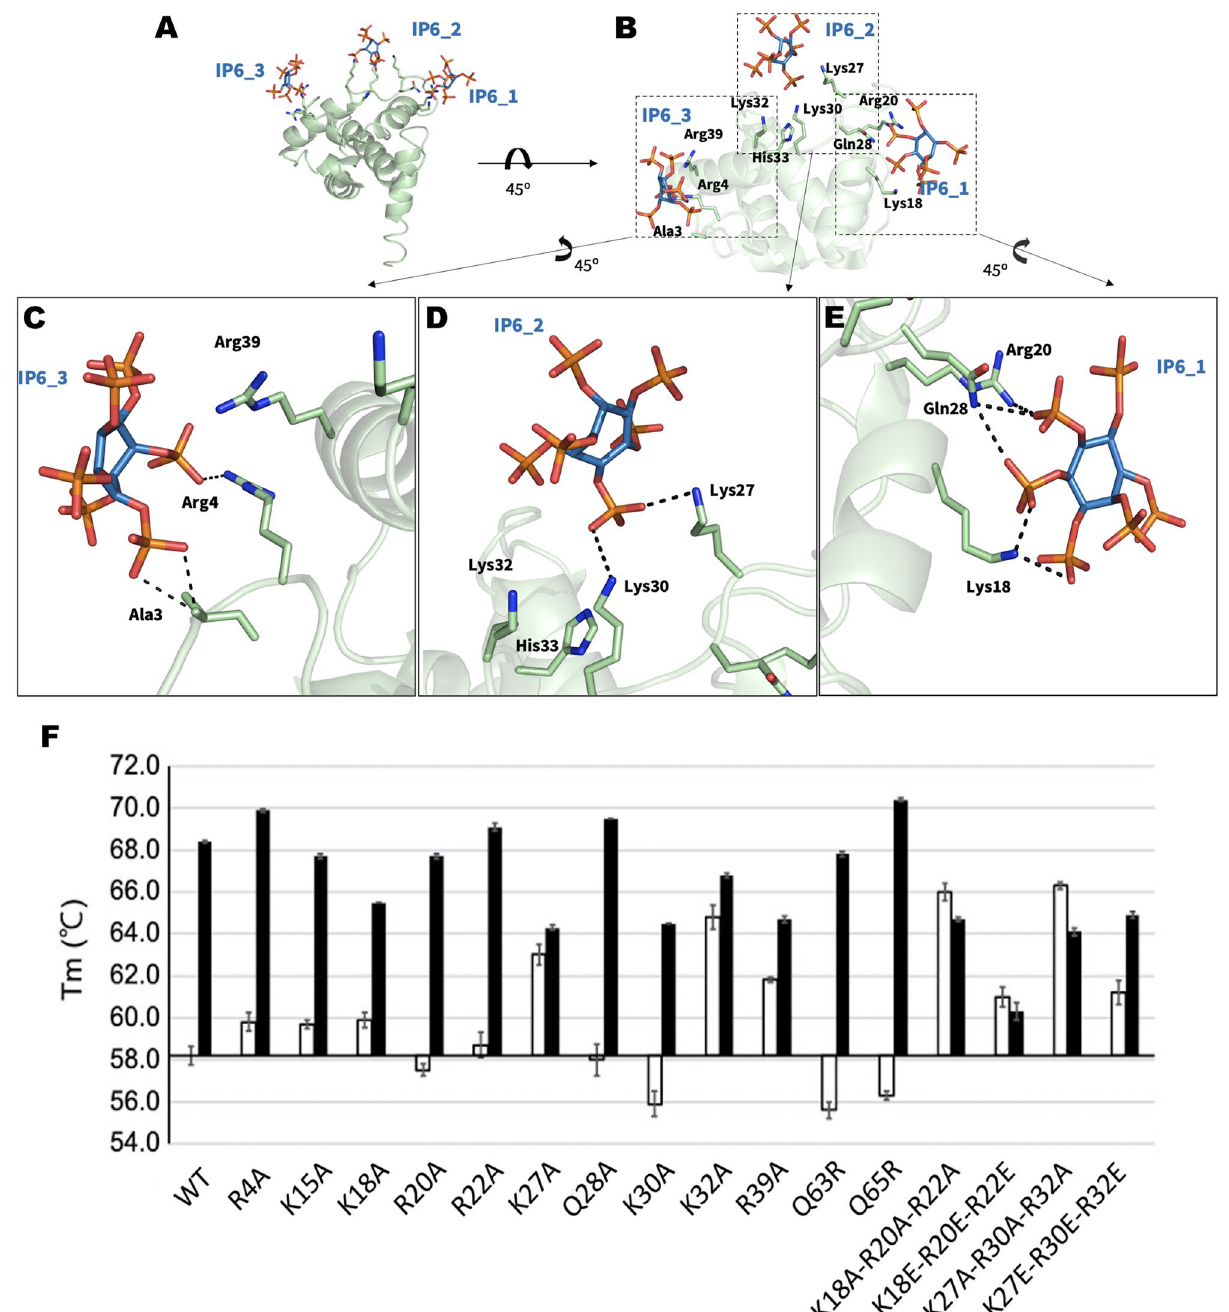
Figure 4. IP6-interacting amino acid residues of MA. ( a ) IP6 molecules near chain A and its symmetry mates of MA are shown in sky-blue and the side chain of amino acid residues in 5.0 Å is shown by sticks (pale green). ( b ) The three IP6 molecules are represented with their interacting residues on chain A. The interaction between ( c ) IP6_3 ( d ) IP6_2 ( e ) IP6_1 and chain A of the MA domain is shown in more detail. ( f ) DSF assay results of point mutations of MA in the presence (black bars) and in the absence of IP6 (white bars). Melting temperatures (Tm) of the wild-type and mutant proteins are indicated after normalization with wild-type protein Tm in the absence of